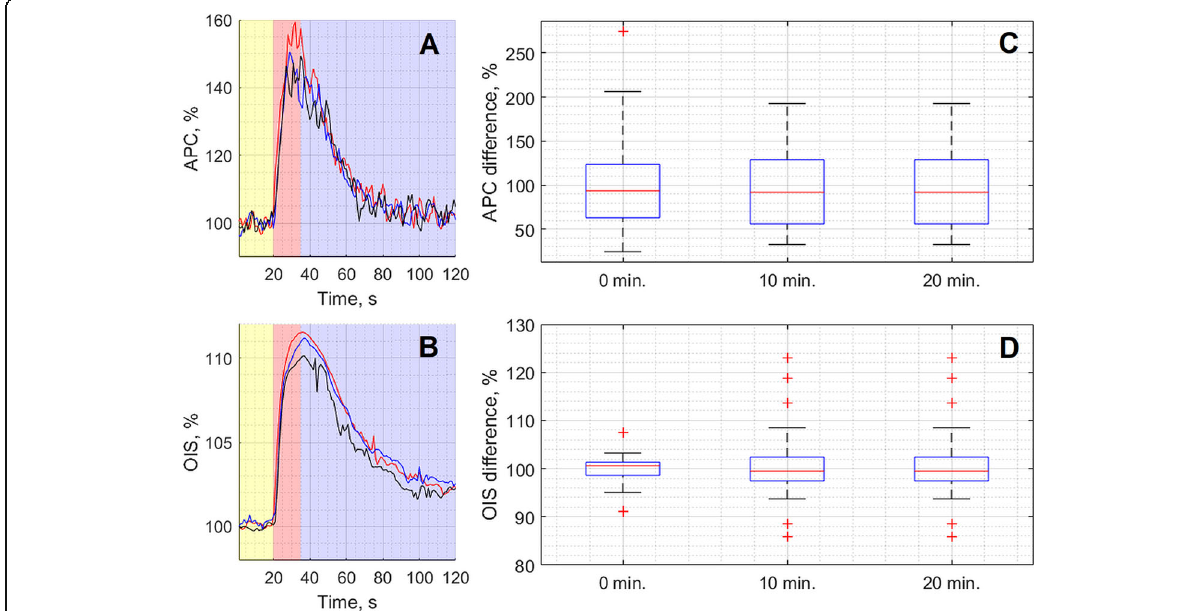
Fig. 4 Representative example of the responses of optical parameters APC (panel a ) and OIS (panel b ) to three subsequent CCW electrical stimulations repeated every 10 min for one of the rats during the baseline stage. Each curve in panels a and b shows dynamics of APC and OIS parameters averaged for the selected two most representative ROIs. The red curve was obtained in the first trial (0 min), the blue in the second trial (10 min), and the black in the third trial (20 min). The box plots in the panels c and d show cumulative changes in the responses to the stimulation of APC and OIS, respectively. In the panels c and d , the response was estimated as an integral of the respective curve shown in graph a or b (see details in the text). The data were obtained every 10 min for all rats ( n =32) in the baseline stage (before pharmacological interventions)